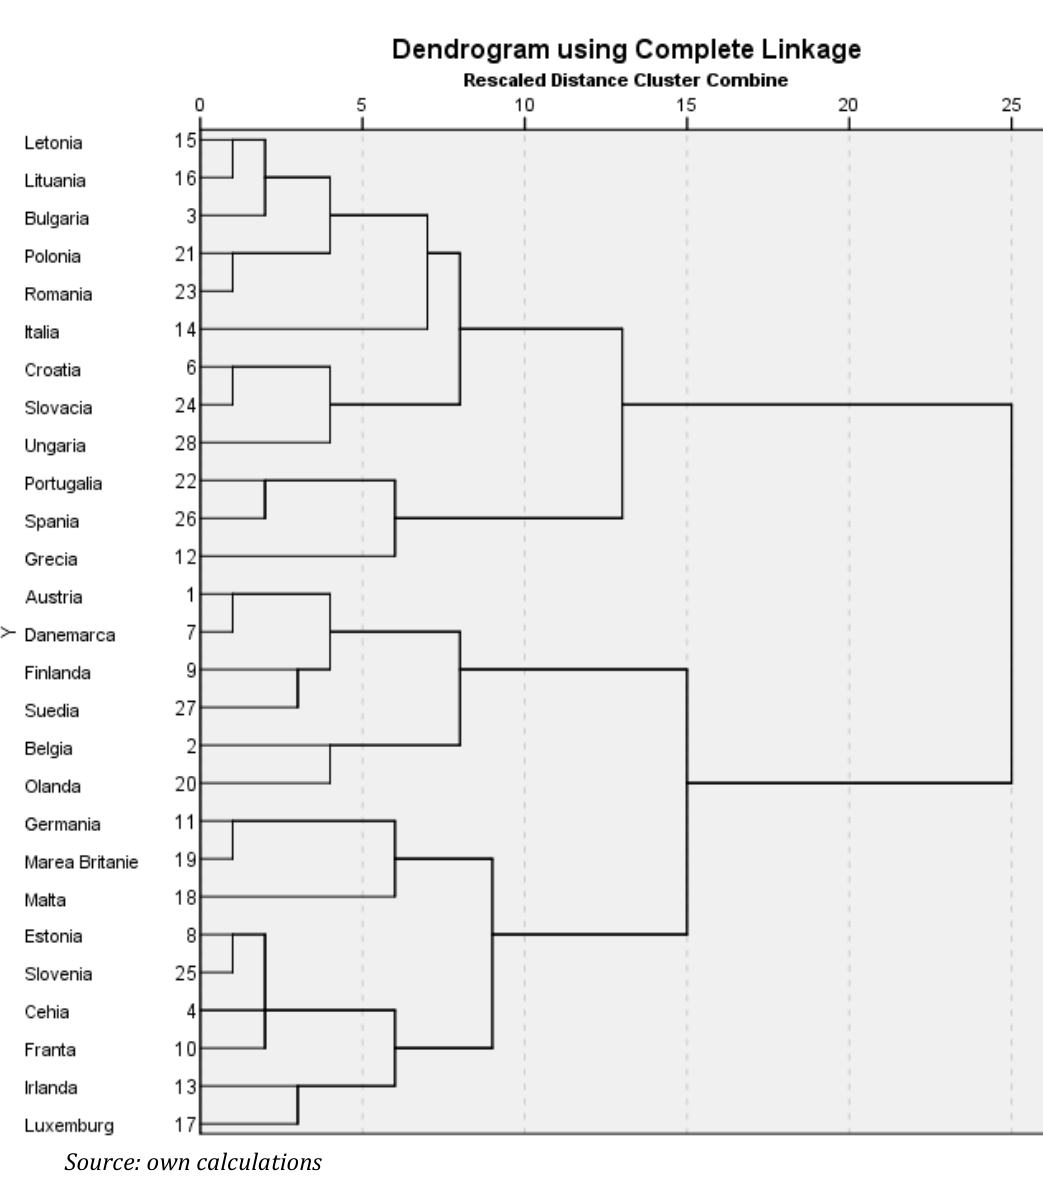
Figure 1: Dendogram